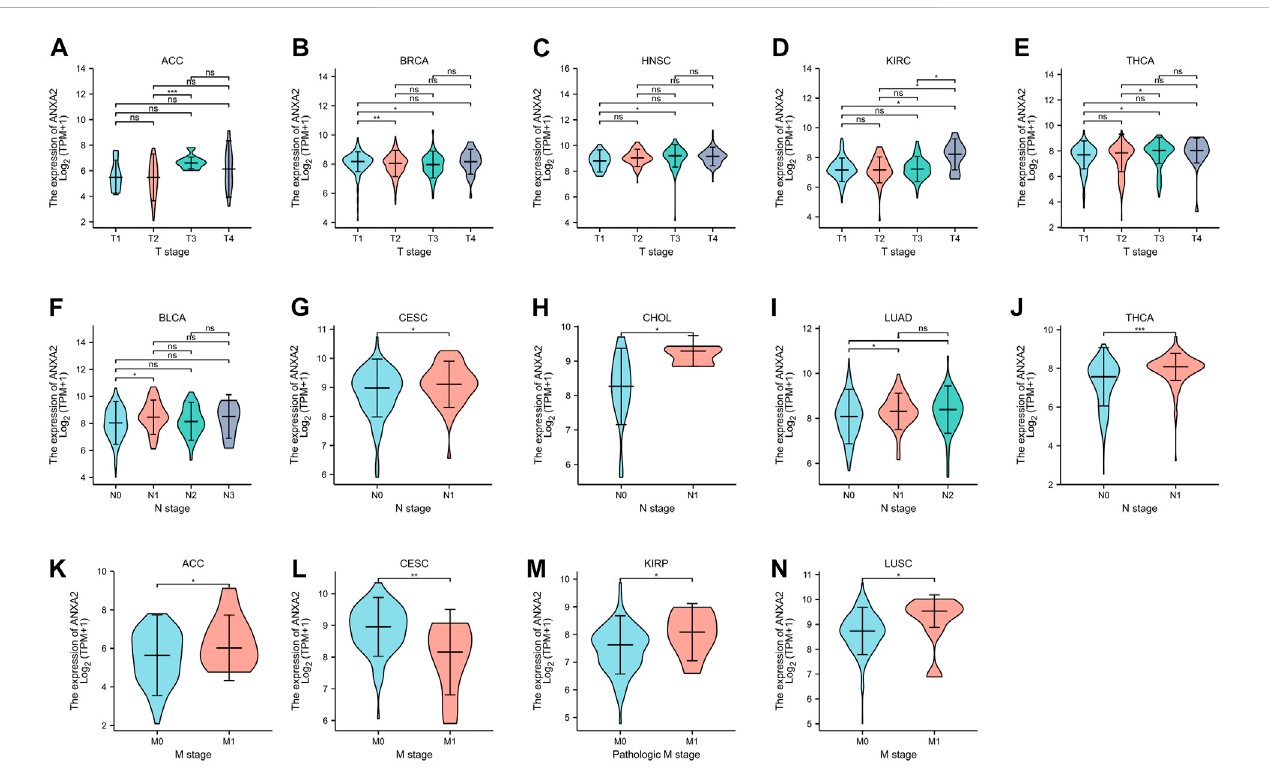
FIGURE 5 Relationship between ANXA2 expression and clinical TNM staging in pan-cancer. (A – E) Relationship between ANXA2 expression and clinical T stage in ACC, BRCA, HNSC, KIRC and THCA. (F – J) Relationship between ANXA2 expression and clinical N stage in BLCA, CESC, CHOL, LUAD and THCA. (K – N) Relationship between ANXA2 expression and clinical M stage in ACC, CESC, KIRP and LUSC. * p < .05, ** p < .01 and *** p <